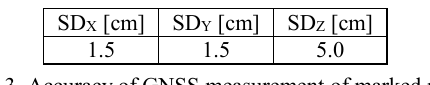
Table 3. Accuracy of GNSS measurement of marked points Where SD is standard deviation of X, Y and Z coordinate.